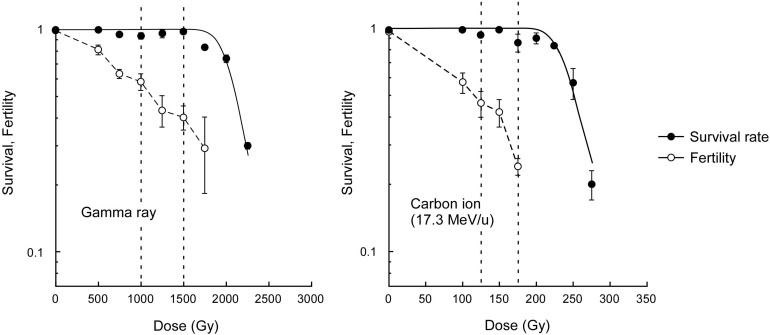
Dose-response relationships for survival rate and fertility of Arabidopsis plants derived from dry seeds irradiated with gamma rays and carbon ions. Closed and open circles represent survival rate and fertility, respectively. Survival curves were drawn on the basis of the single hit-multitarget theory as described in the Materials and methods section. Dotted lines represents 50% and 75% of the dose corresponding to the shoulder of the survival curve (Dq). Fertility represents ratio of the number of fertilized ovules to the total number of ovules. Data points are mean ± standard error of three replications with more than 25 plants for survival, and with more than 15 siliques for fertility. Data for carbon ions are from Hase et al. (2018).